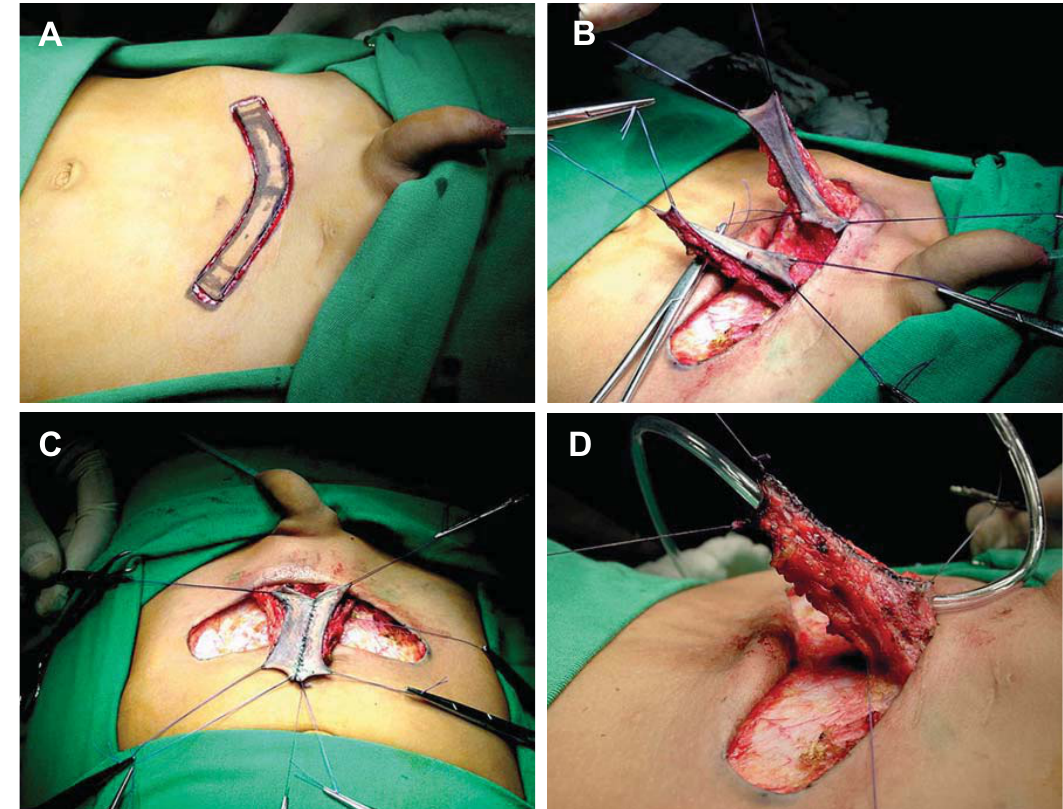
Figure 3 – (cid:3)(cid:38)(cid:82)(cid:81)(cid:86)(cid:87)(cid:85)(cid:88)(cid:70)(cid:87)(cid:76)(cid:82)(cid:81)(cid:3)(cid:82)(cid:73)(cid:3)(cid:87)(cid:75)(cid:72)(cid:3)(cid:87)(cid:88)(cid:69)(cid:72)(cid:3)(cid:90)(cid:76)(cid:87)(cid:75)(cid:3)(cid:87)(cid:90)(cid:82)(cid:3)(cid:86)(cid:78)(cid:76)(cid:81)(cid:3)(cid:192)(cid:68)(cid:83)(cid:86)(cid:3)(cid:76)(cid:81)(cid:3)(cid:87)(cid:75)(cid:72)(cid:3)(cid:191)(cid:85)(cid:86)(cid:87)(cid:3)(cid:83)(cid:68)(cid:87)(cid:76)(cid:72)(cid:81)(cid:87)(cid:3)(cid:82)(cid:83)(cid:72)(cid:85)(cid:68)(cid:87)(cid:72)(cid:71)(cid:3)(cid:90)(cid:76)(cid:87)(cid:75)(cid:3)(cid:87)(cid:75)(cid:76)(cid:86)(cid:3)(cid:87)(cid:72)(cid:70)(cid:75)(cid:81)(cid:76)(cid:84)(cid:88)(cid:72)(cid:17)